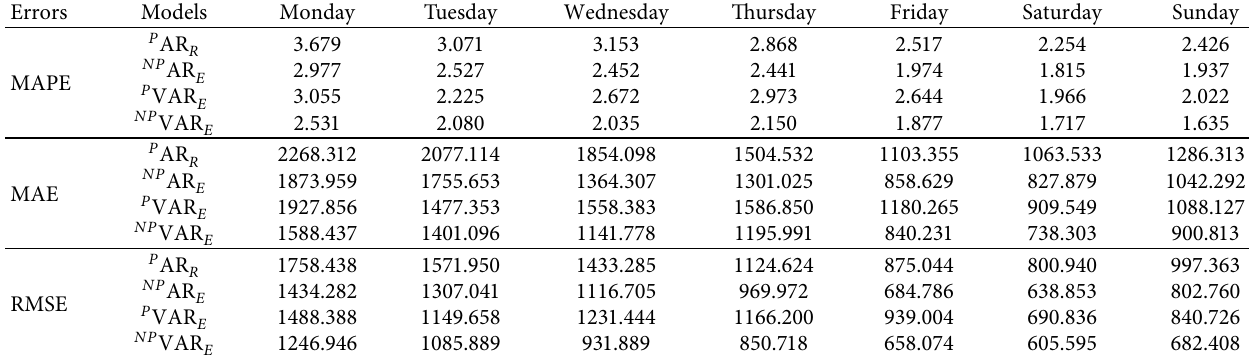
Table 5: Day-specific descriptive statistics for the electricity demand.